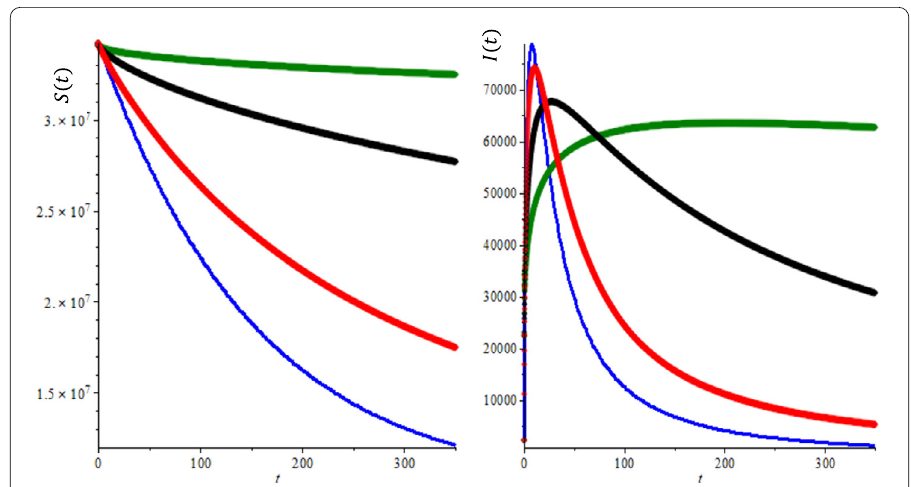
Figure 5 Comparison of between the results of integer order derivatives (blue line, α = 1), fractional order of derivatives ( α = 0.9 (red line), α = 0.7 (black line) and α = 0.5 (green line) for b = 100, k = 3000 and R 0 =